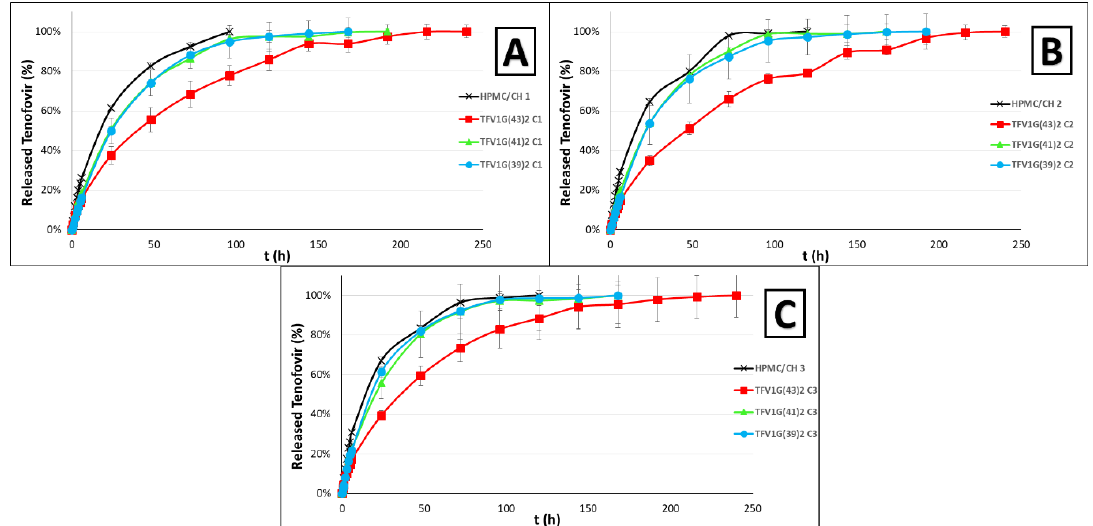
Figure 10. TFV release profiles obtained from batches containing TFV/Gelucire® (in a ratio of 1:2) granules in HPMC/CH matrices with equal ratios of both polymers ( A ); more HPMC than CH ( B ); and more CH than HPMC ( C ). All are compared with standard formulations of HPMC/CH [16].